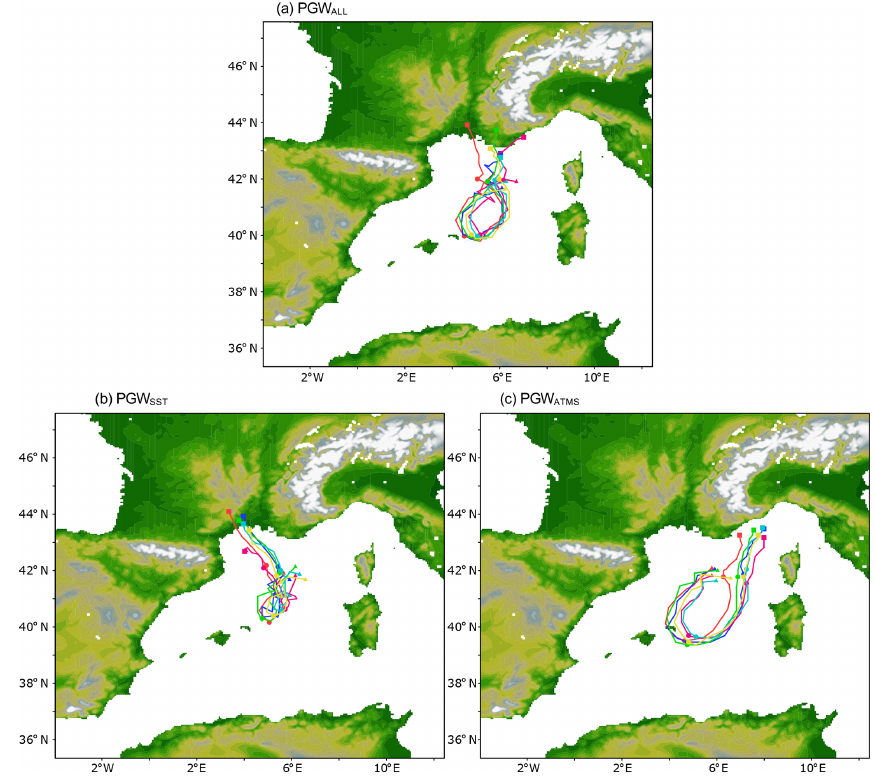
Figure 5. Same as Fig. 3, but for (a) PGW ALL , (b) PGW SST , and (c) PGW ATMS . Note that the track of TD_TP_MN (red), TD_W5_MN (blue), and TD_W6_MN (green) in PGW SST terminates at 15:00–08:00UTC due to the early